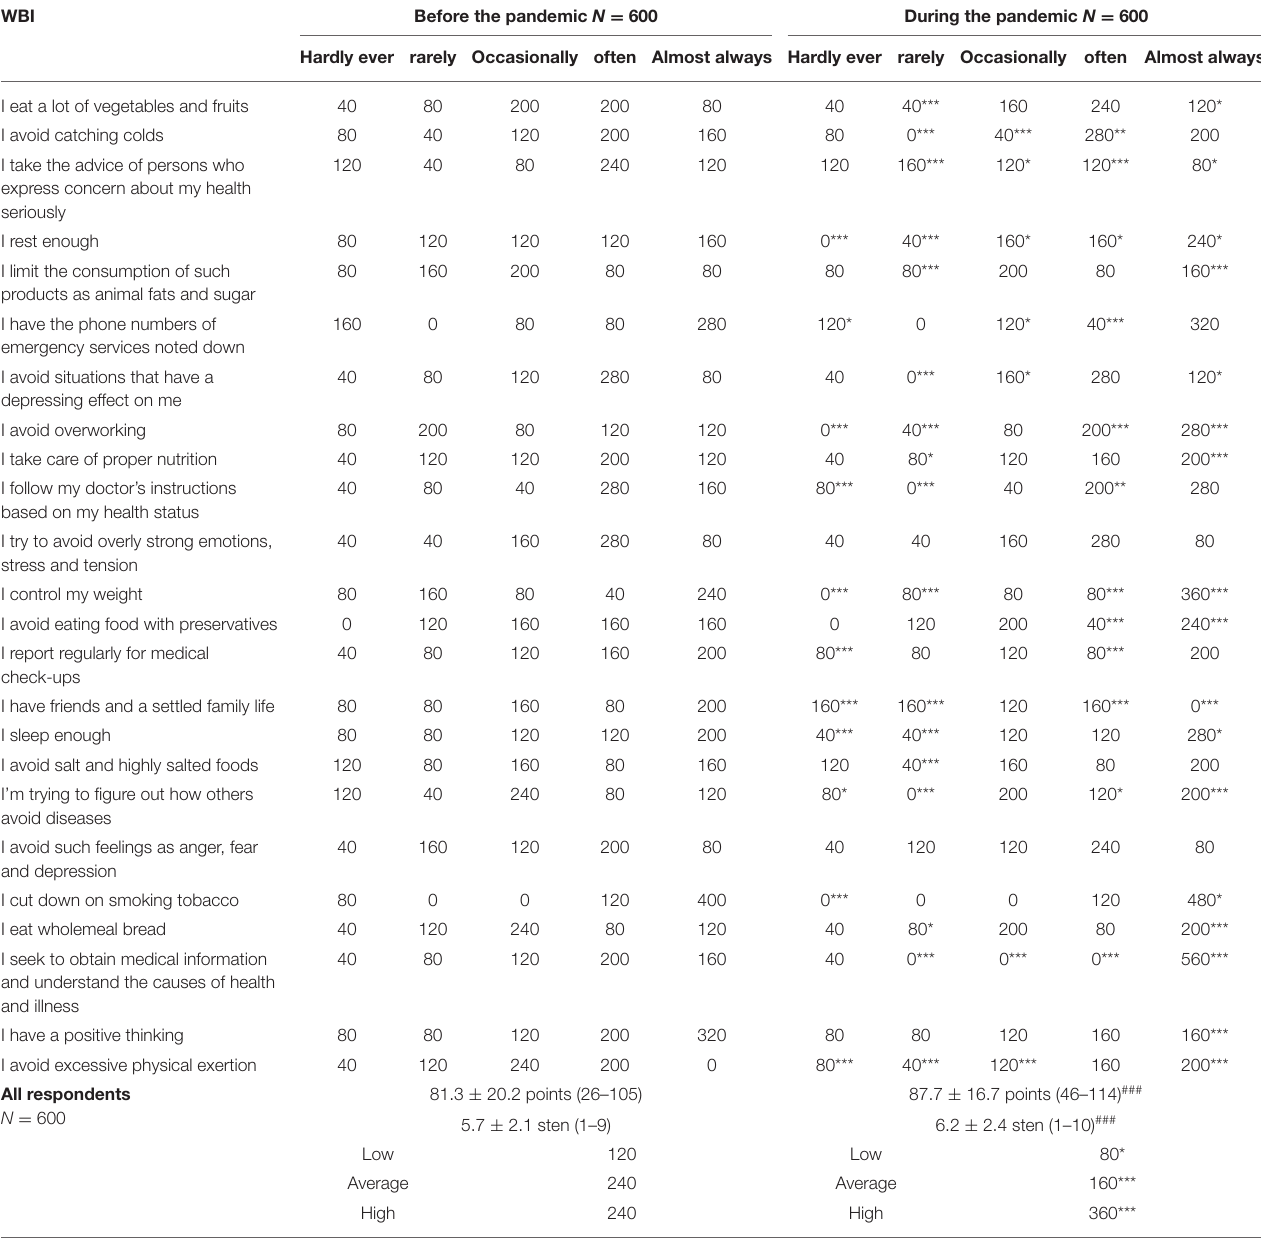
TABLE 4 | The type of health-related behaviors before and during the pandemic presented by all respondents. WBI Before the pandemic N = 600 During the pandemic N =